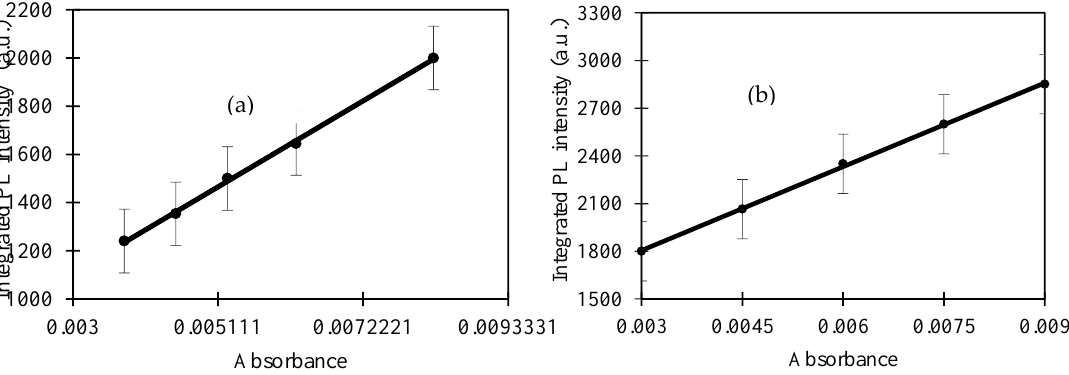
Figure 3. The variation of the integrated fluorescence with absorbance of ( a ) quinine sulfate (QS) and ( b ) CQD, respectively (number of replicates: 3). Table 2. Comparison of the quantum yield of carbon quantum dots reported in the previous studies. Types of Carbon Quantum Dots (CQD)